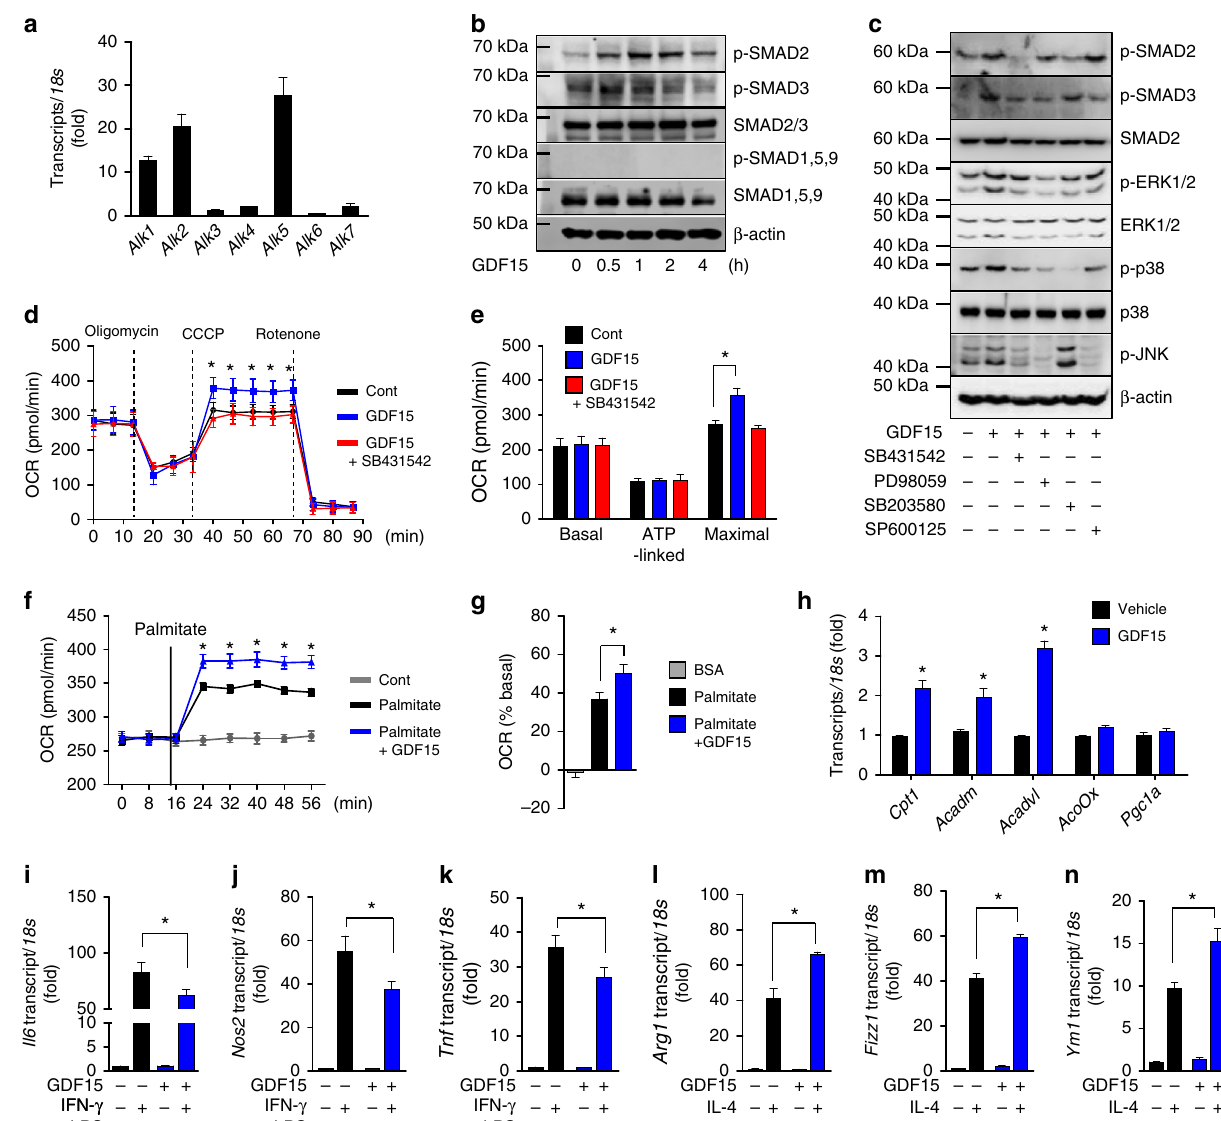
Fig. 4 GDF15 promotes oxidative metabolism and M2-like polarization. a Real-time PCR analysis of TGF- β RI ( Alk1 – 7 ) expression in BMDMs. b Immunoblot analysis of rGDF15-induced phosphorylation of SMAD2 and 3. c Immunoblot analysis of rGDF15-induced phosphorylation of SMAD2, SMAD3, ERK1/2, p38, and JNK, which was inhibited by the chemical inhibitors, SB431542 (an ALK4, 5, 7 inhibitor; 5 μ M), PD98059 (an ERK1/2 inhibitor; 25 μ M), SB203580 (a p38 inhibitor; 10 μ M), and SP600125 (a JNK inhibitor; 10 μ M). d , e OCR in BMDMs treated with rGDF15 (300 ng/ml) for 24 h with or without SB431542 (5 μ M). f , g Fatty acid oxidation in BMDMs treated with rGDF15 (300 ng/ml) for 24 h with or without palmitate-BSA (200 μ M). h Real-time PCR analysis of FAO-related genes in rGDF15 (300 ng/ml)-treated BMDMs. i – k Real-time PCR analysis of M1-related gene expression in rGDF15 (300 ng/ml)-treated BMDMs in the presence of IFN- γ (10 ng/ml) and LPS (100 ng/ml). ( l – n ) Real-time PCR analysis of M2-related gene expression in rGDF15-treated BMDMs in the presence of IL-4 (20 ng/ml). Data are expressed as means ± SEM and are representative of three independent experiments. * p < 0.05 or ** p < 0.01 (two-tailed Student ’ s t